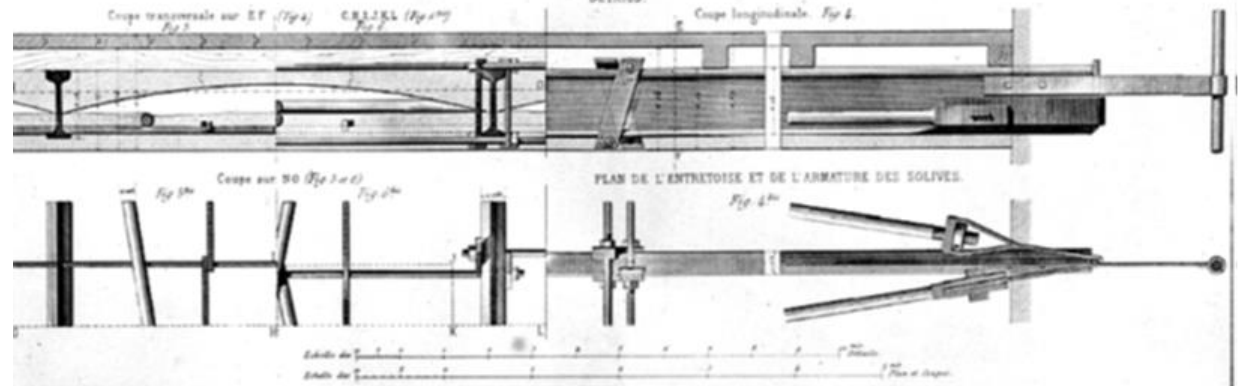
Figure 29. Patent for light metallic structures. Part of the article written by Bleuze in the magazine “Revue Générale et des Travaux Publics”, 1858. Vol.6, (Pl.34). Published by César Daly. Reference [49].